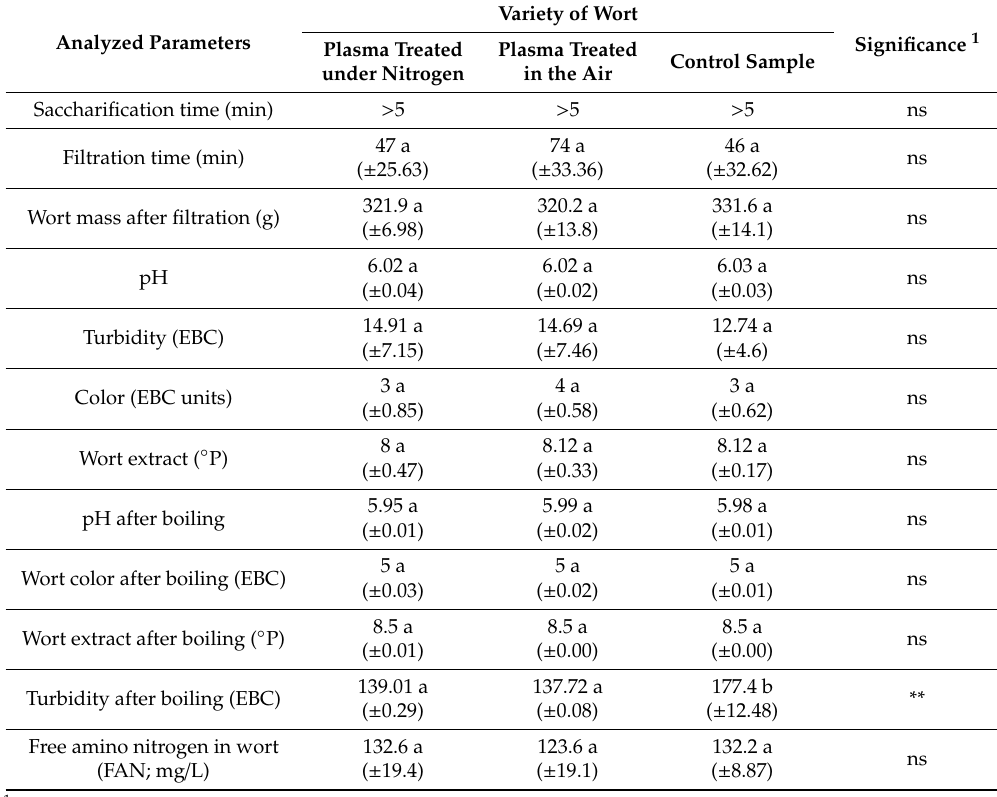
Table 3. Quality parameters of the obtained wort.